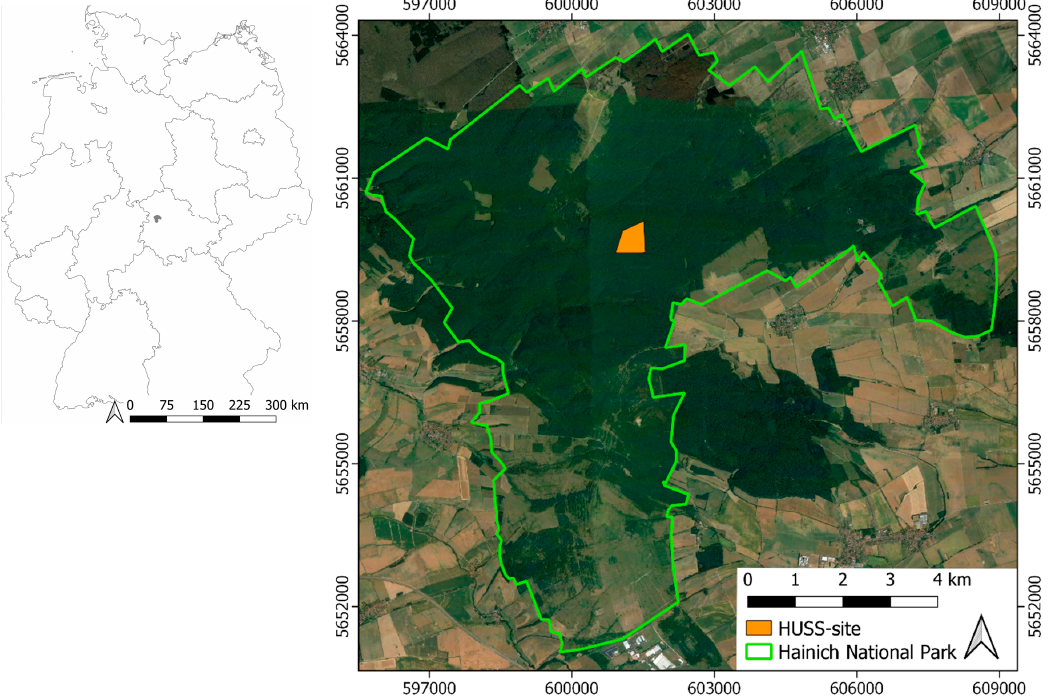
Figure 1. Overview of the study area. The Hainich National Park is located in the center of Germany. The Huss supersite is part of the core area of the park. The satellite imagery in the backdrop is taken from Google Earth (2020). The coordinate system used for all figures of this paper is universal transverse mercator (UTM), zone 32N, ellipsoid WGS84.